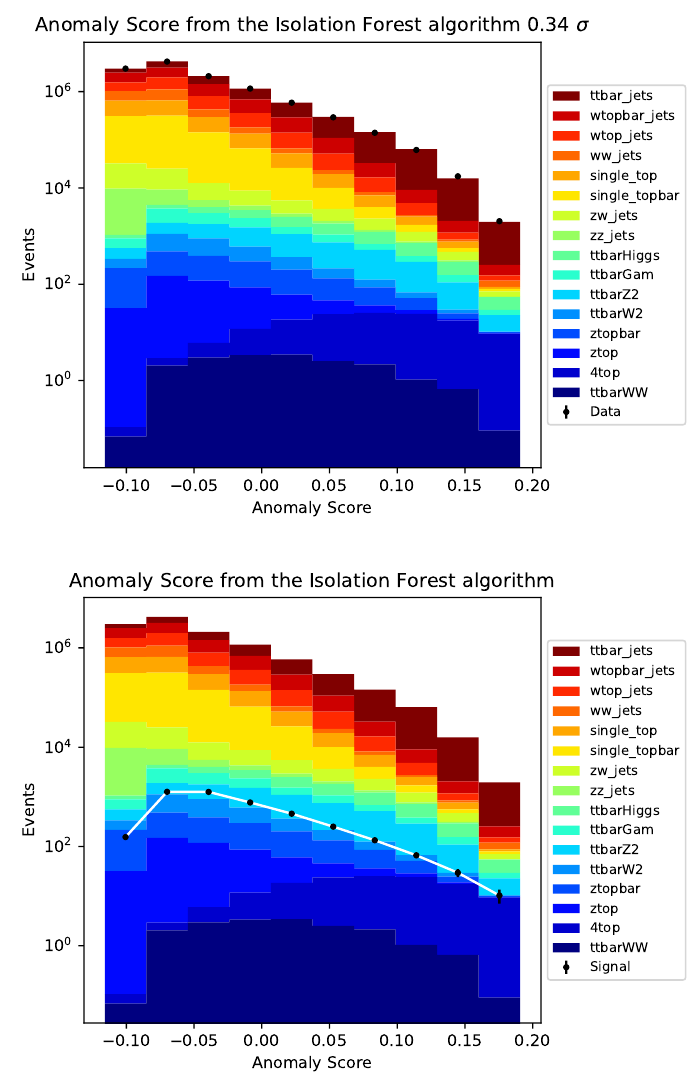
Figure 3. Results from the isolation forest tested on supersymmetric top quark data. On the left is a histogram of background alongside pseudo-data, and on the right is a histogram of background and pure signal. Note that the right-most histogram would not be observed in nature and is purely for